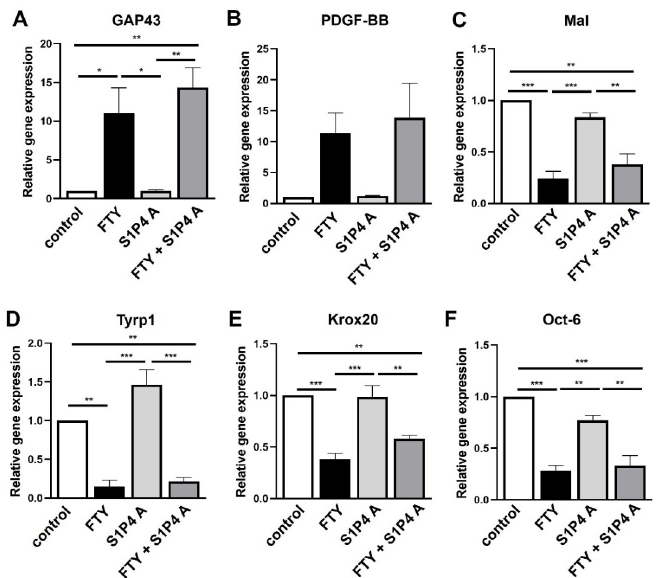
Figure 7. Neutralization of the S1P4 receptor does not affect the Schwann cell phenotype. qRT-PCR based quantification of gene expression upon application of an S1P4 antagonist (S1P4 A, CYM50358) alone as well as in combination with Fingolimod (FTY + S1P4 A) revealed no effect on the expression of GAP43 ( A ), PDGF-BB ( B ), Mal ( C ), Tyrp1 ( D ), Krox20 ( E ) and Oct-6 ( F ) whereas Fingolimod alone led to the typical expression pattern of all markers. For statistical analysis, a one-way ANOVA with Tukey’s multiple comparison test was used, * p < 0.05, ** p < 0.01, *** p < 0.001 ( n = 3).